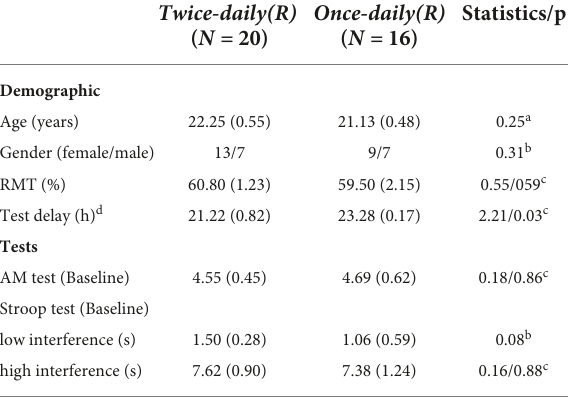
Table 1 . ANOVA indicated no significant Group [ Combined(R) vs. Twice-daily(S) ] × Time (baseline vs. post-rTMS) interaction. See details in the Supplementary material